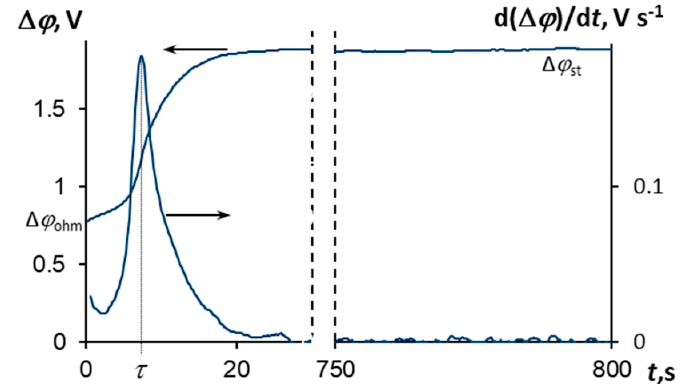
Figure 5. Chronopotentiogram of the MK-40 membrane in the 0.04 M MgCl 2 solution, ∆ ϕ vs. t , and its derivative, d( ∆ ϕ ) / d t vs. t , in the model solution at i = 1.9 i lim . ∆ ϕ ohm is the ohmic potential drop just after the current is switched on; ∆ ϕ st is the potential drop at the quasi-steady state; τ is the transition time.